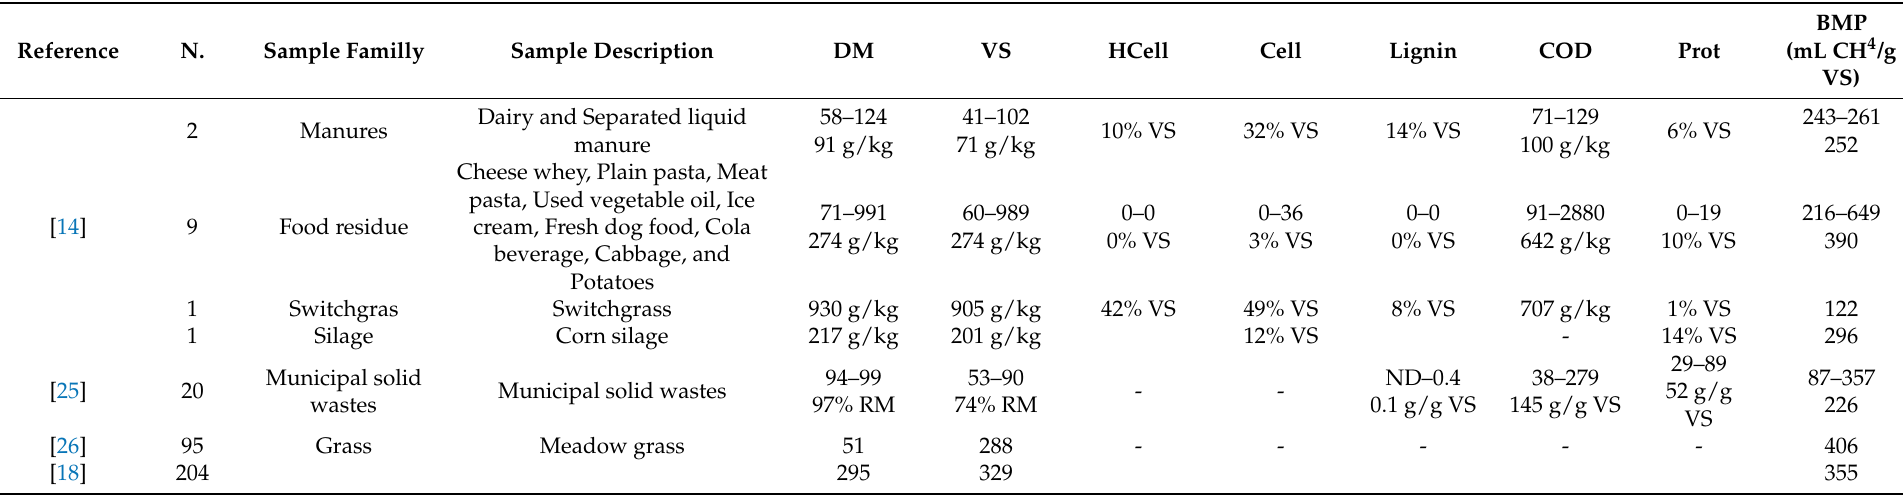
Table A3. Literature references of BMP performed on large samples, biogas production and biochemical characterization are indicated for each families of